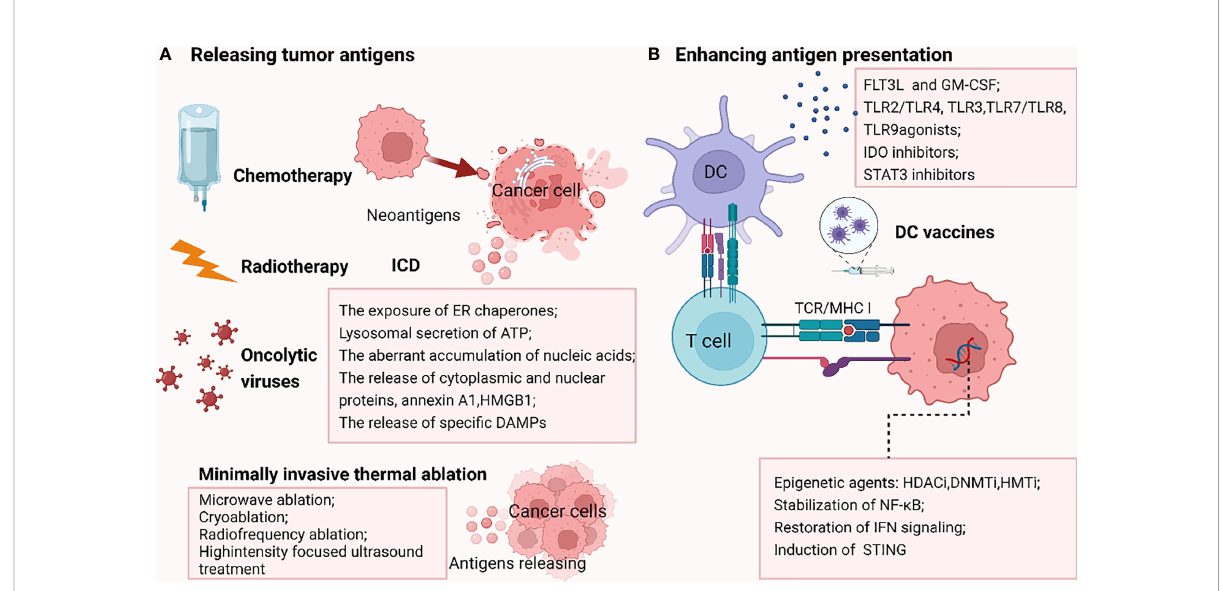
FIGURE 3 Strategies reversing PD-1/PDL1 blockade by releasing tumor antigens (A) and enhancing antigen presentation (B) . A.Chemotherapy, radiotherapy and oncolytic viruses could promote the immunogenic cell death (ICD), enhancing the liberation of immunogenic neoantigens, thus increasing the antigenicity in tumors resistant to ICB due to the failure of antigen recognition. In addition, some minimally invasive thermal ablation treatments lead to antigens release as well. (B) DNMTi, HDACi, HMTi epigenetically modulate the upregulation of MHC pathway. Stabilization of NF- k B, restoration of IFN signaling and induction of stimulator of interferon genes (STING) also reverse MHC-I downregulation. Besides, stimulation factors including cytokines such as FLT3L (FMS-like tyrosine kinase 3 ligand) and GM-CSF (granulocyte – macrophage colony- stimulating factor), Toll-like receptor (TLR2/TLR4, TLR3, TLR7/TLR8, TLR9) agonists, IDO inhibitors and STAT3 inhibitors could augment the in fi ltration, activation, and effector function of conventional DCs (cDCs), thus increasing antigen delivery. DC vaccines are also important tools boosting antigen presentation. The picture was created with BioRender.com. ICD, immunogenic cell death; STING, stimulator of interferon genes; FLT3L, FMS-like tyrosine kinase 3 ligand; GM-CSF, granulocyte – macrophage colony-stimulating factor; TLR, Toll-like receptor; IDO, indoleamine- (2,3)-dioxygenase; DC, dendritic